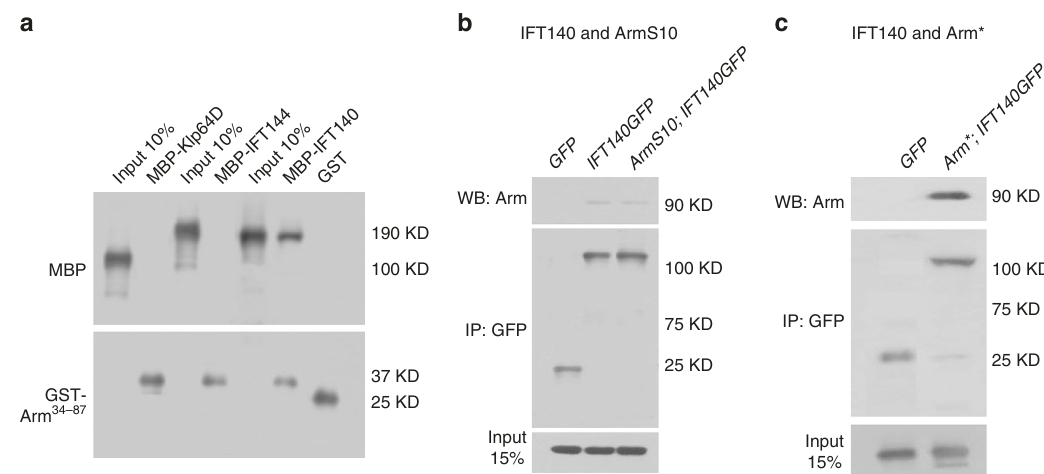
Fig. 7 Physical interaction between Klp64D, IFT140, and Arm34-87. a GST pull-down between Klp64D or IFT140 and Arm34-87. IFT140 directly binds to amino acids 34 − 87 of Arm, whereas Klp64D does not. IFT144 does not bind to Arm34-87, as a negative control. b , c ) Co-immunoprecipitation assay of IFT140 and ArmS10 from wing imaginal discs of C96 > GFP , C96 > ArmS10; > IFT140-GFP (both in b ), and C96 > Arm* ; > IFT140-GFP (panel ( c )) genotypes. Protein extracts from wing discs were IP-ed with anti-GFP. The immune complexes and input (15% of wing disc lysates used in IP step) were analyzed by immunoblotting with anti-Arm antibody. b IFT140 does not bind ArmS10; note that the weak background band is also present in wt control GFP lane and represents endogenous Arm (middle lane; as con fi rmed by its migration behavior; ArmS10 is a deletion and migrates faster). c IFT140 forms strong association with independently of the cilium, and this function is conserved in mammals and promotes nuclear translocation of Arm/ β -Catenin.